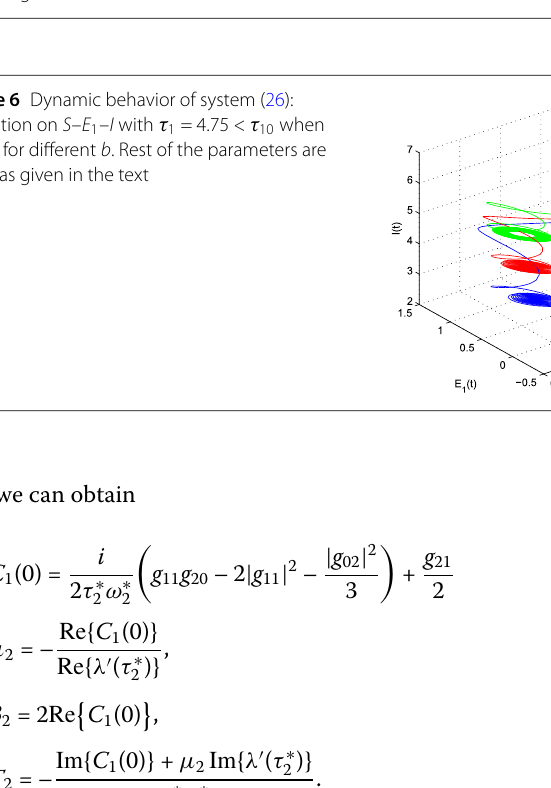
Figure 5 Time plots of S , E 1 E 2 and I for different b at τ 1 = 4.25 < τ 10 when τ 2 = 0. Rest of the parameters are taken as given in the text